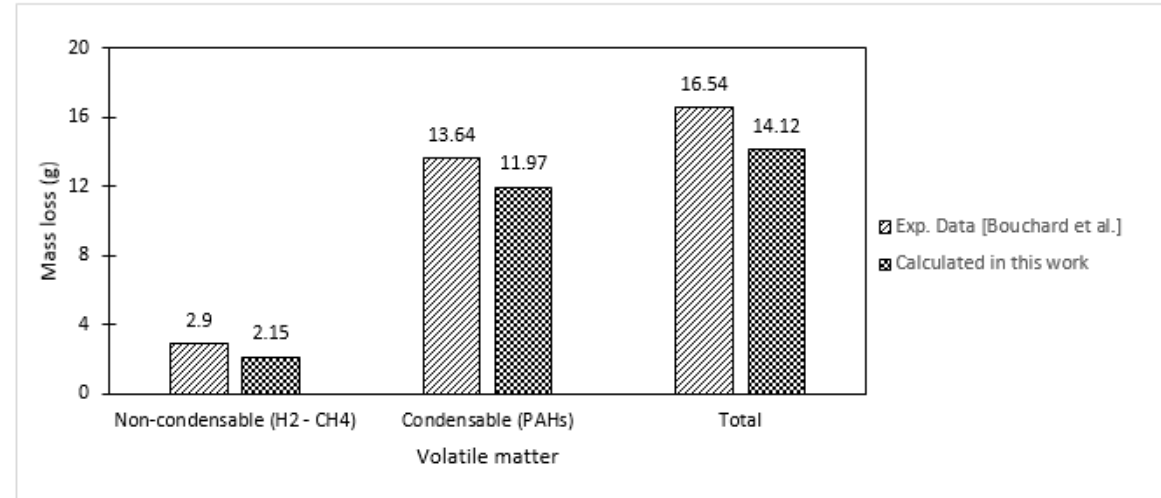
Figure 14. Calculated released volatile matters from a 50 g coal tar pitch in temperature range of Tamb–550 °C during carbonization process with heating rate of 50 °C/h (Experimental data obtaine from work of Bouchard et al in ref. [28]).